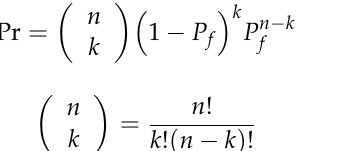
Figure 10. Principal current density-voltage relationship for a SOFC, including deactivation. Re- printed with permission from Ref. [43]. Copyright 2021, Elsevier.